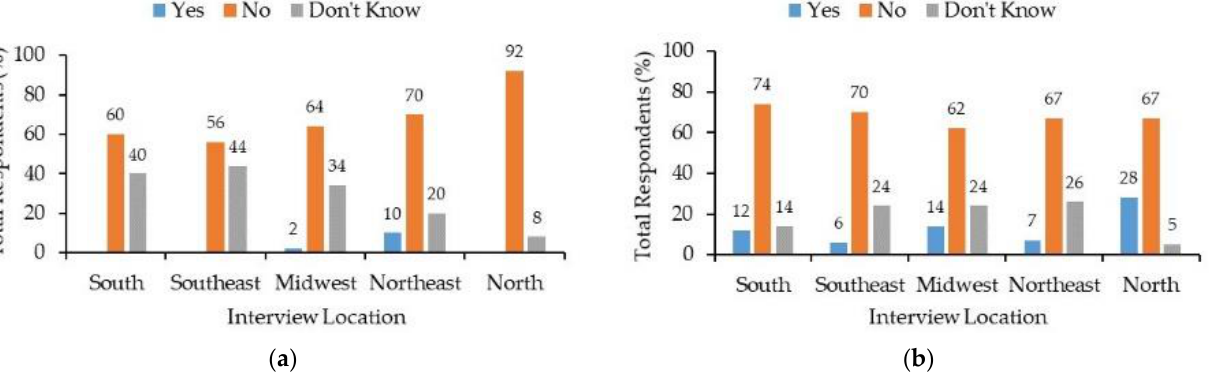
Figure 5. Perception in relation to electromagnetic interference ( a ), and perception regarding the risks of accidents with Avifauna ( b ), according to the total number of interviewees by region. Source: elaborated by the author.